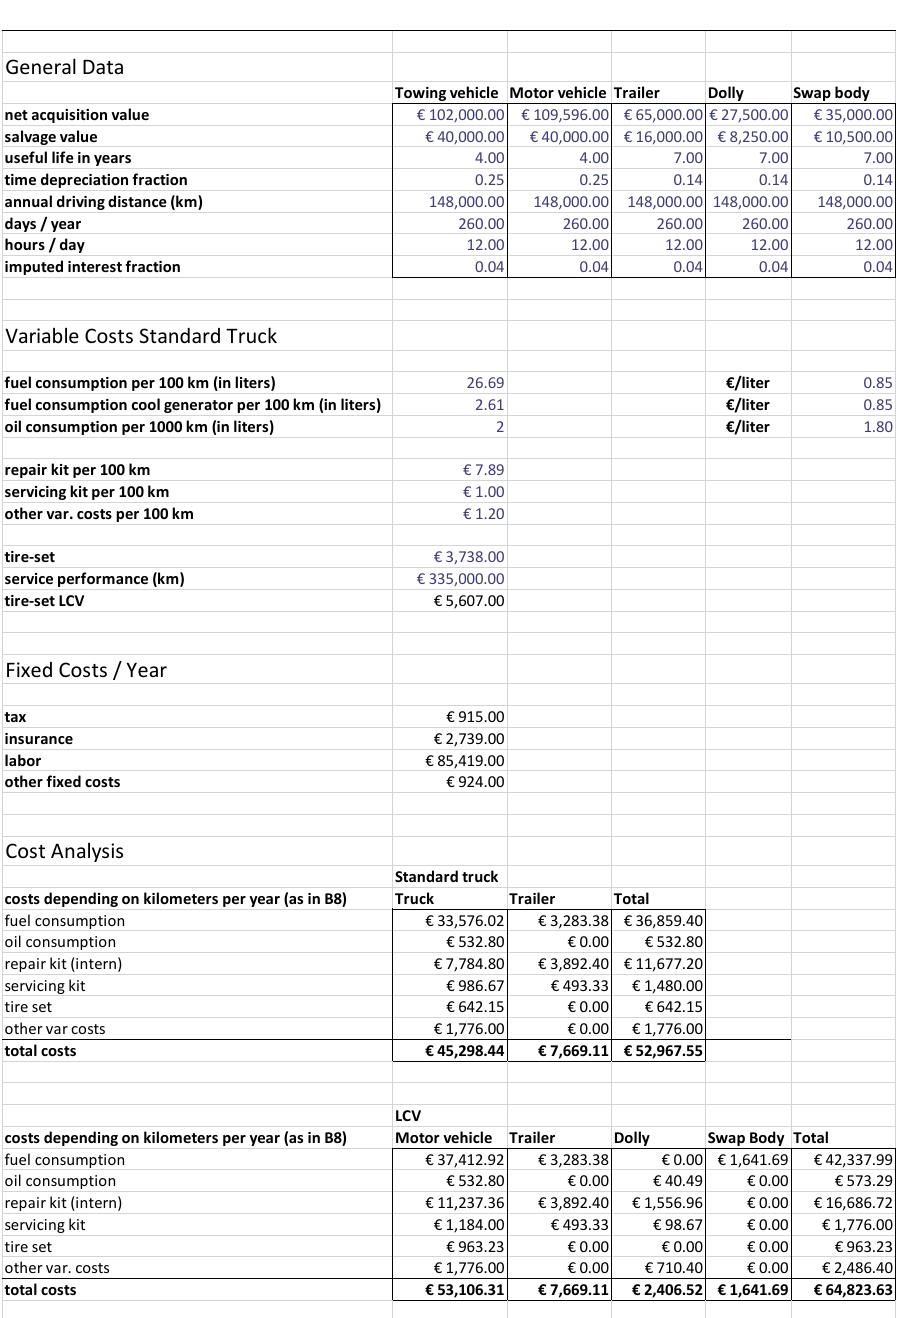
Table A1. Detailed cost breakdown for the actual and accurate costs (including driver) in € per km, both for a standard truck, as well as for a long combination vehicle.